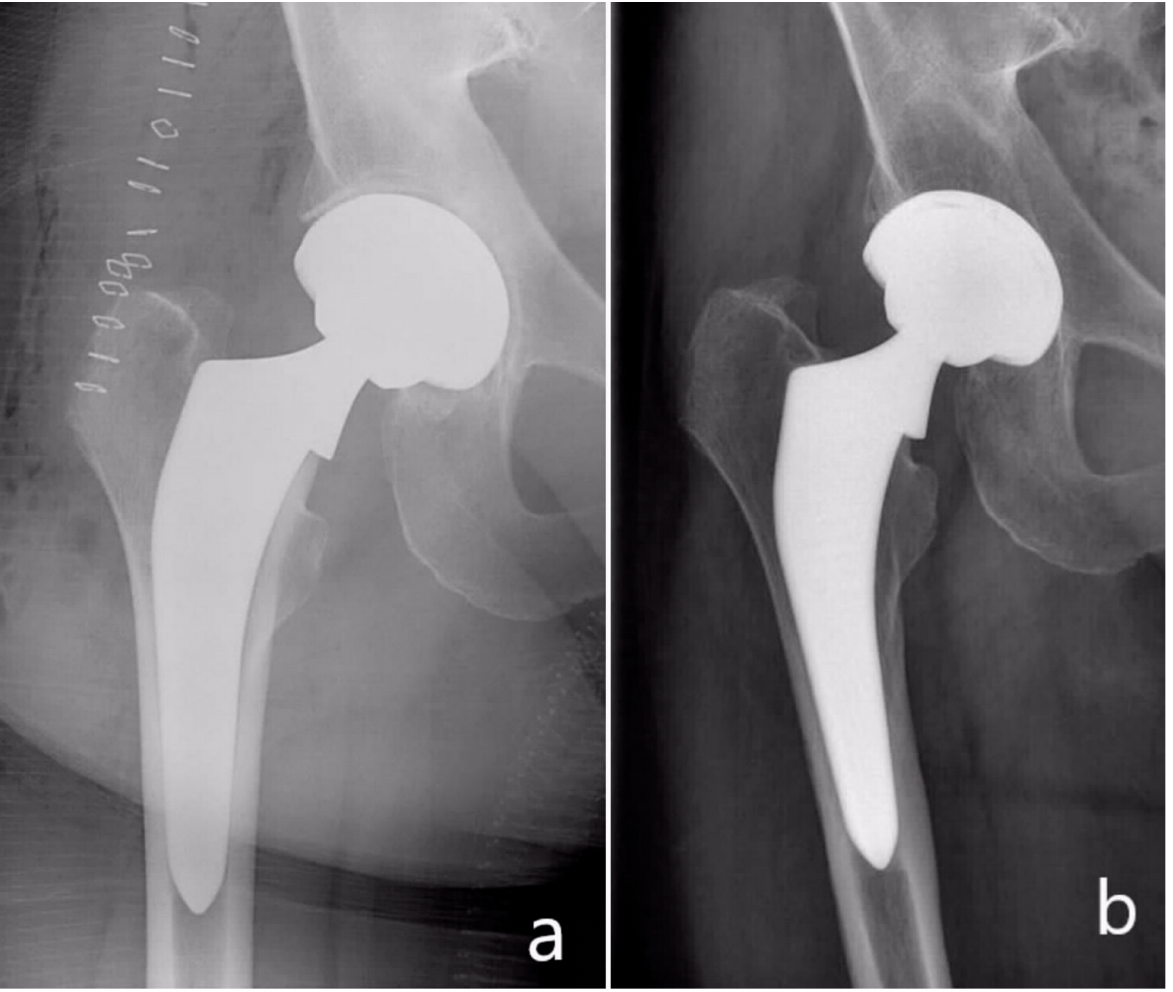
Figure 5. ( a ) Postoperative radiograph, ( b ) radiograph of the same patient at three months showing subsidence of the